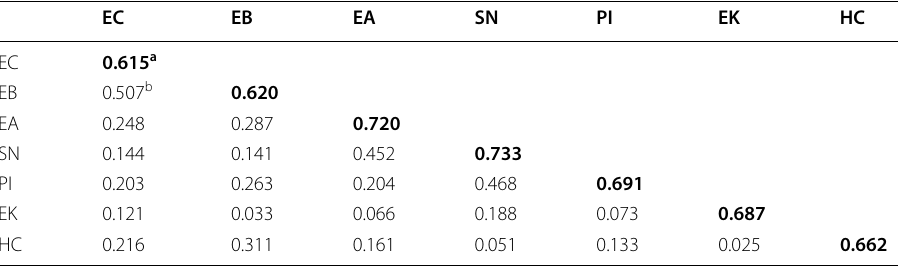
Table 3 The squared correlations and AVE of variables